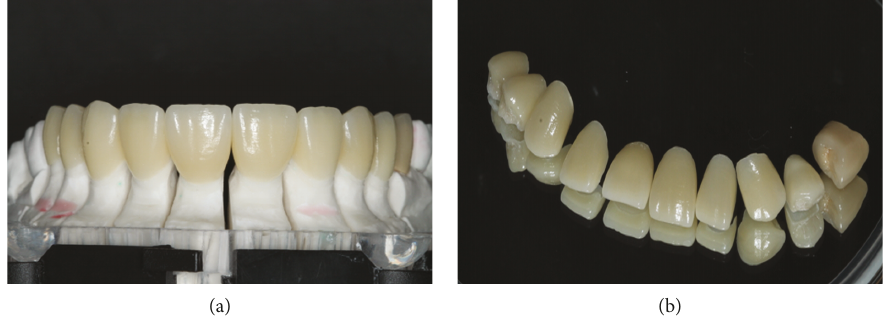
Figure 8: (a) Finished parts in the die-cut model. (b) Veneers in feldspathic ceramics.